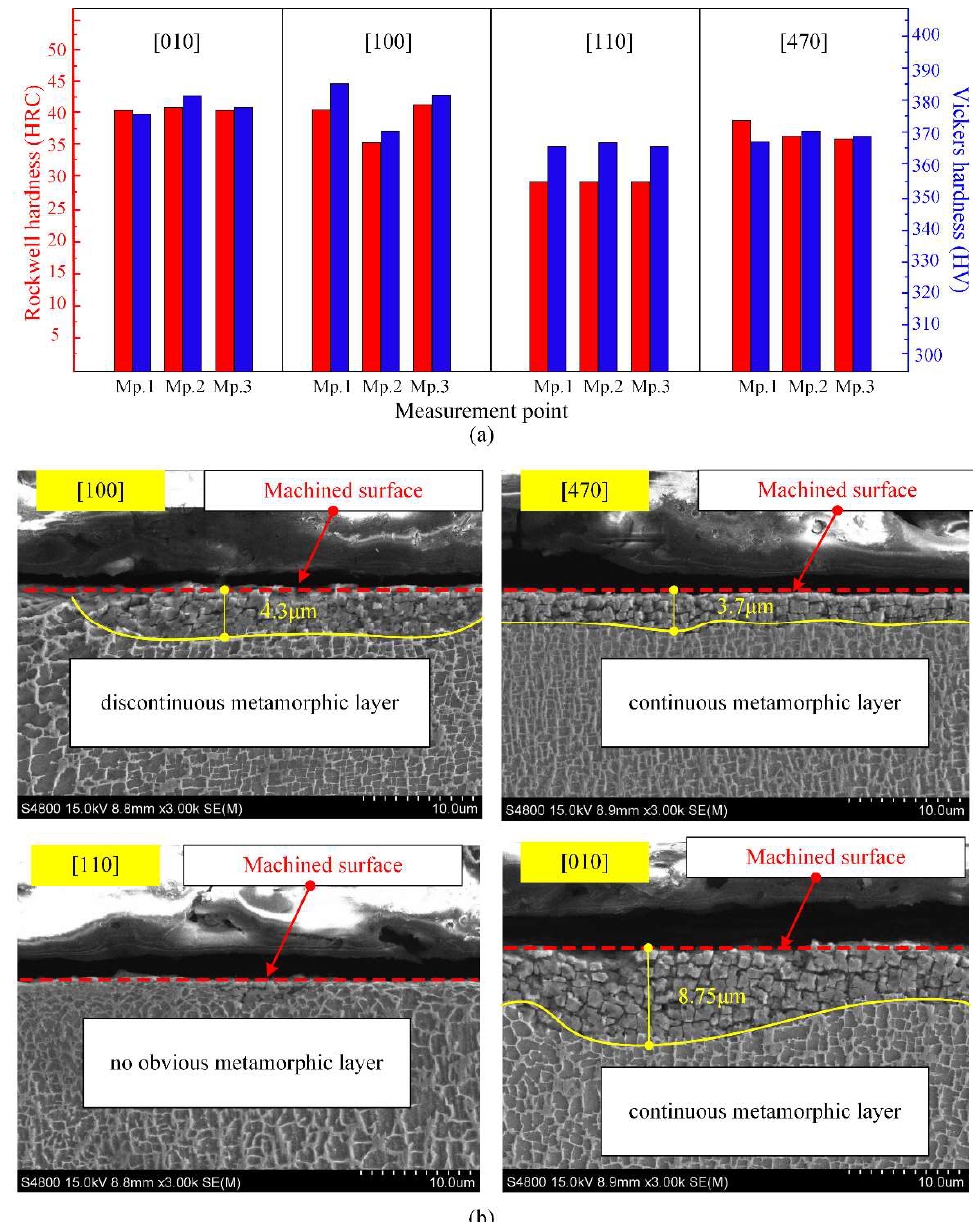
Figure 7. ( a ) Hardness test results and ( b ) subsurface metamorphic layer.